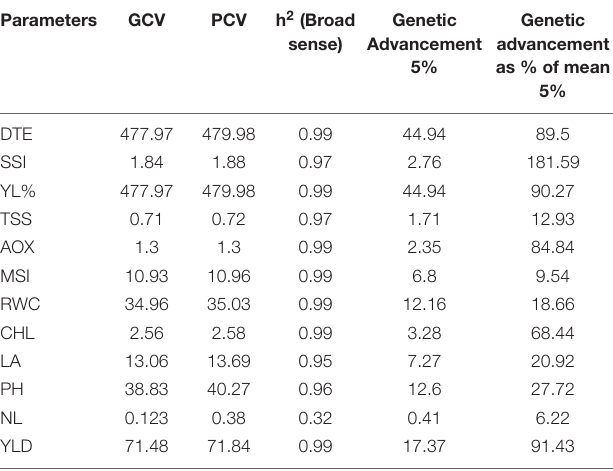
TABLE 8 | Estimates of genetic parameters for 12 quantitative traits of 100 onion genotypes under drought stress